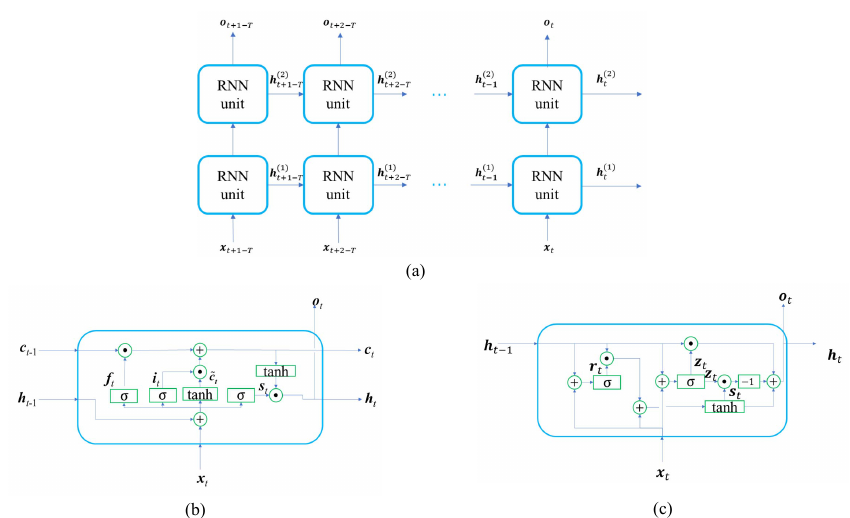
Figure 4. Architecture of the two-layer recurrent neural network. ( a ) Two-layer RNN, whose RNN unit can be realized by LSTM or the Grated Recurrent Unit (GRU). ( b ) LSTM unit. ( c )